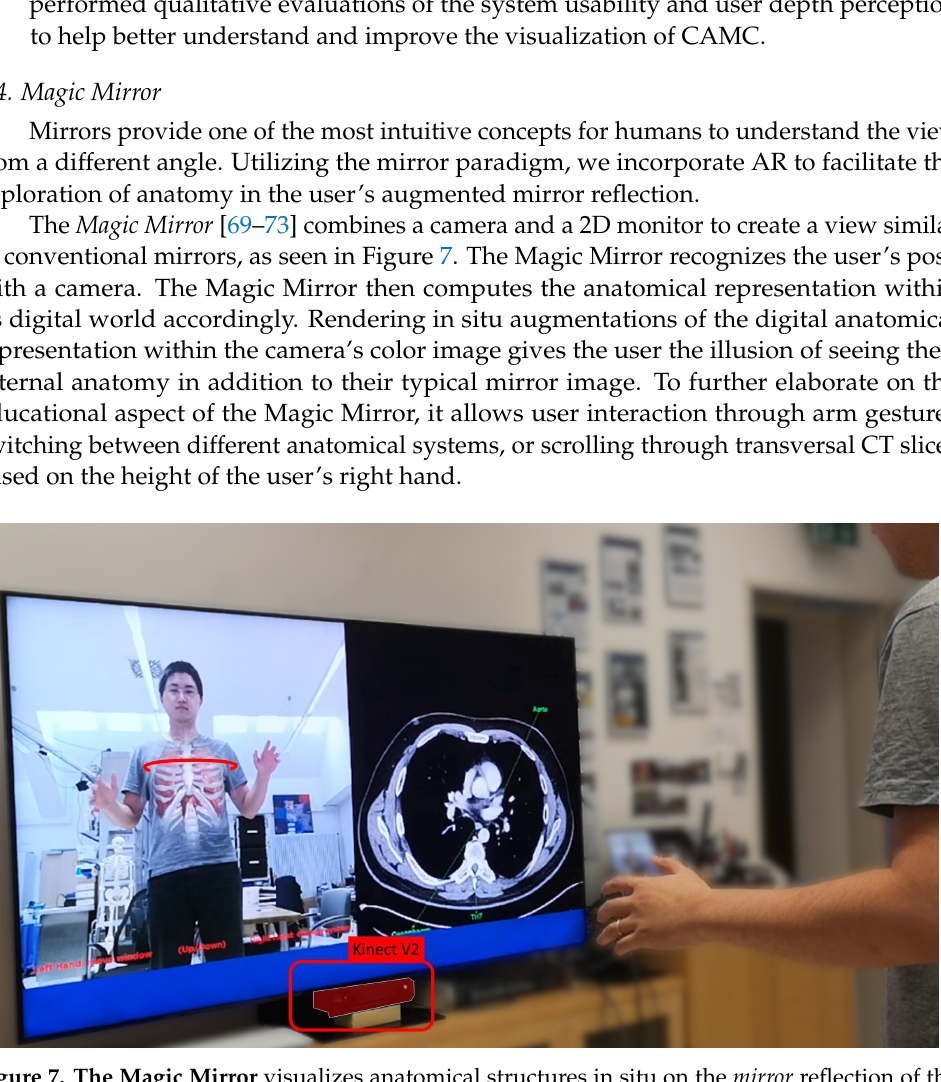
Figure 7. The Magic Mirror visualizes anatomical structures in situ on the mirror reflection of the user in front of the RGB-D camera. Additionally, our Magic Mirror system displays transverse slices of a CT volume on the right half of the monitor that matches the slice selected by the user with their right